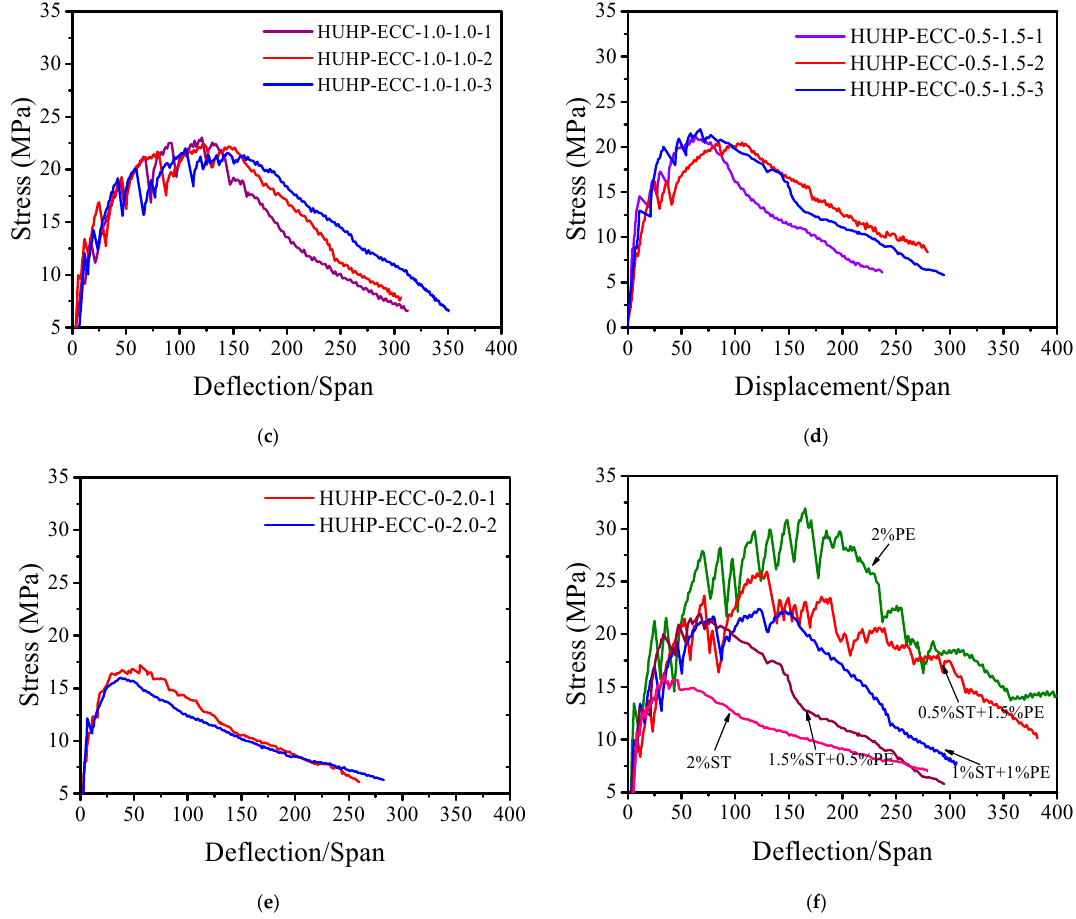
Figure 12. Stress versus displacement curves of HUHP-ECCs. ( a ) HUHP-ECC-2.0-0; ( b ) HUHP-ECC-1.5-0.5; ( c ) HUHP-ECC-1.0-1.0; ( d ) HUHP-ECC-0.5-1.5; ( e ) HUHP-ECC-0-2.0; ( f ) Typical stress versus displacement curves. Materials 2018 , 11, 1448